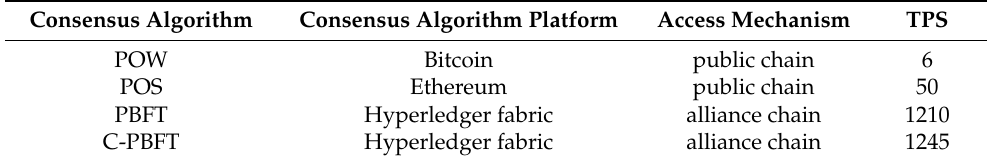
Table 1. TPS values of different consensus